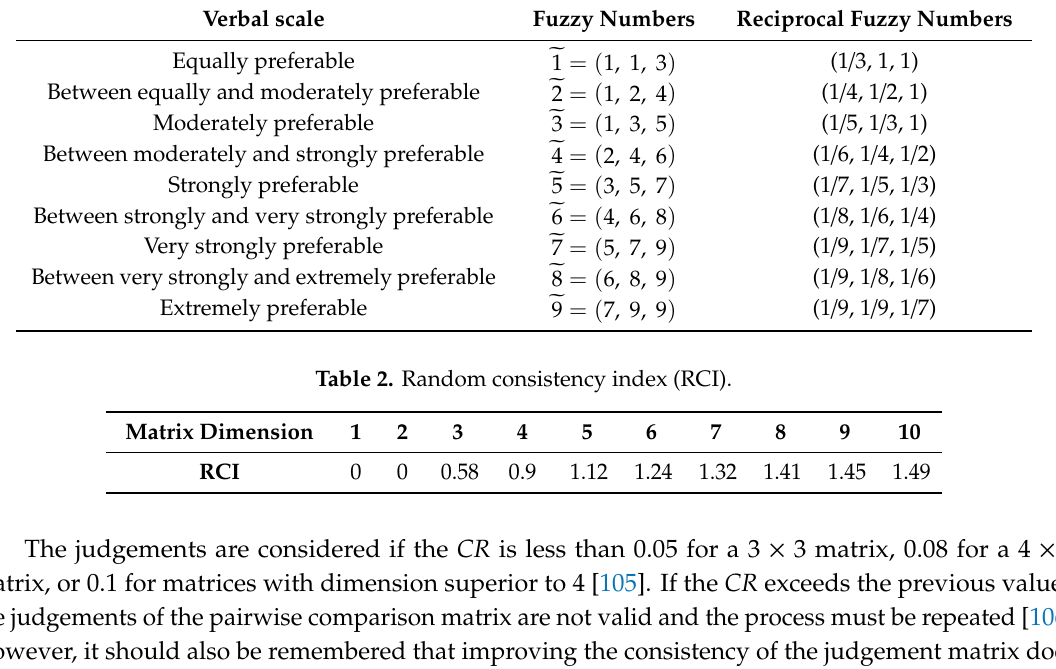
Table 1. Verbal scale and associated fuzzy numbers.